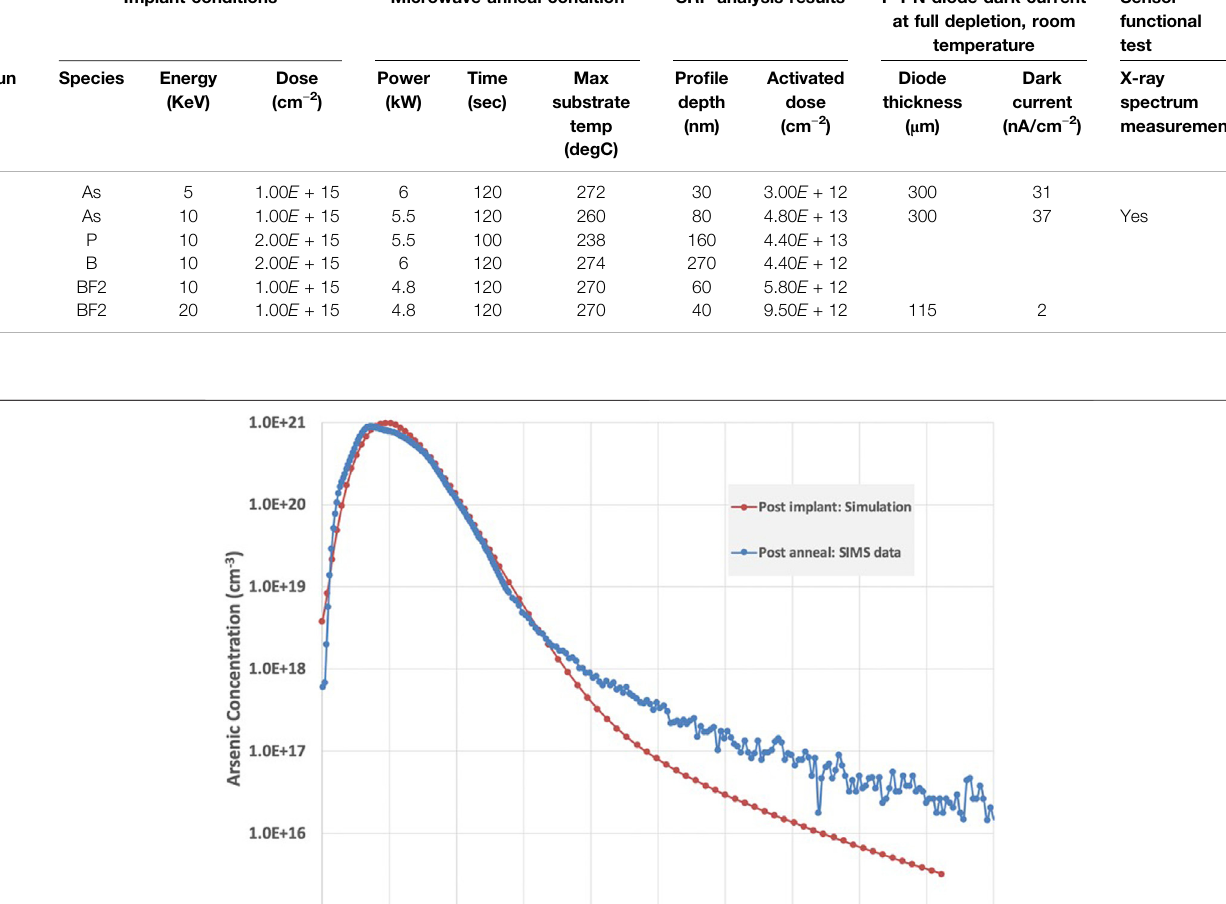
Frontiers in Physics |